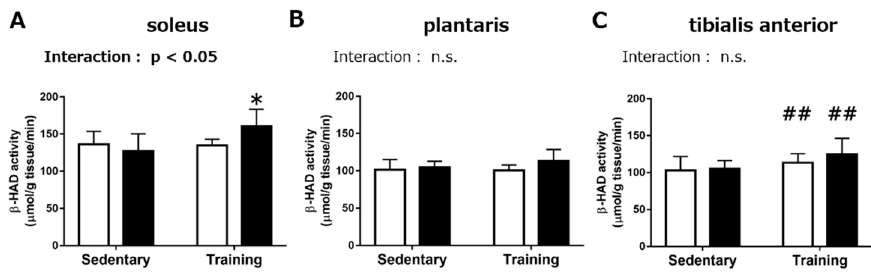
Figure 2. Maximal activity of β -hydroxyacyl CoA dehydrogenase in the soleus ( A ), plantaris ( B ), and tibialis anterior muscle ( C ) of mice that treated with royal jelly (RJ-treated group; black) or distilled water (Control group; white), with or without endurance training for three weeks (Chronic experiment). Values represent mean ± standard error. n = 6–8 per group. ## p < 0.01, main effect of endurance training. * p < 0.05, statistical significance vs the RJ-treated sedentary group. n.s.: not significant.